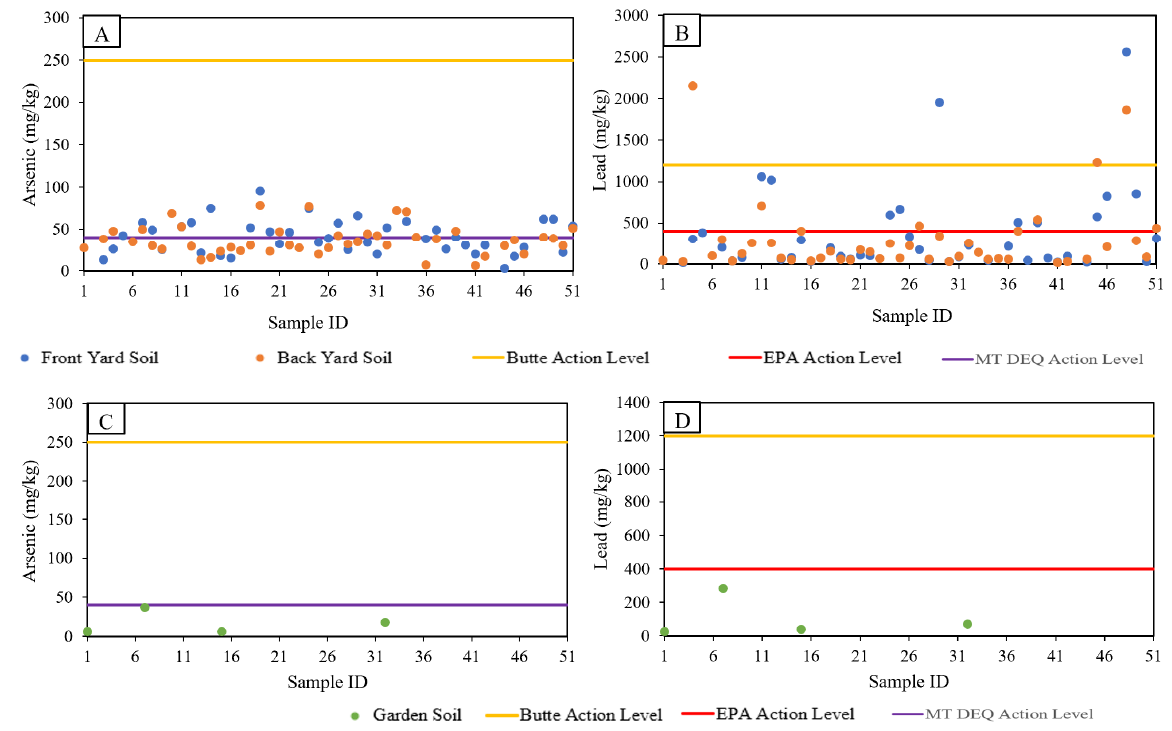
Figure 5. Butte area residential yard soil and garden soil As and Pb concentrations. ( A ) Residential soil As concentrations; ( B ) Residential soil Pb concentrations; ( C ) Garden As concentrations; ( D ) Garden Pb concentrations.